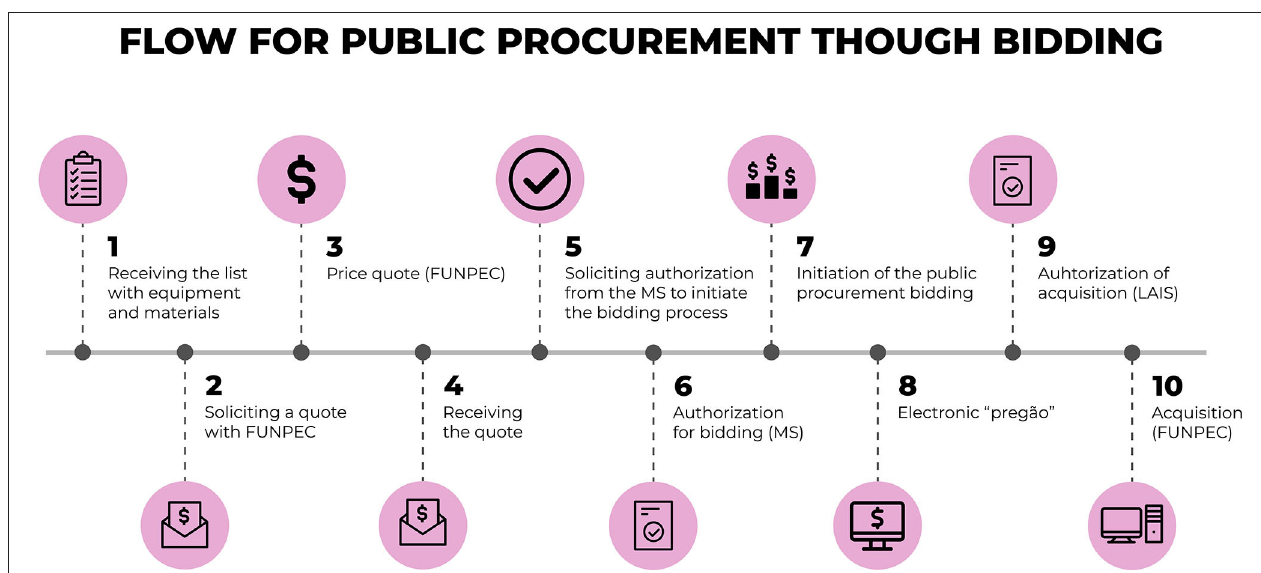
FIGURE 5 | Detailed flow for procurement through bidding. Source: graphic developed by the